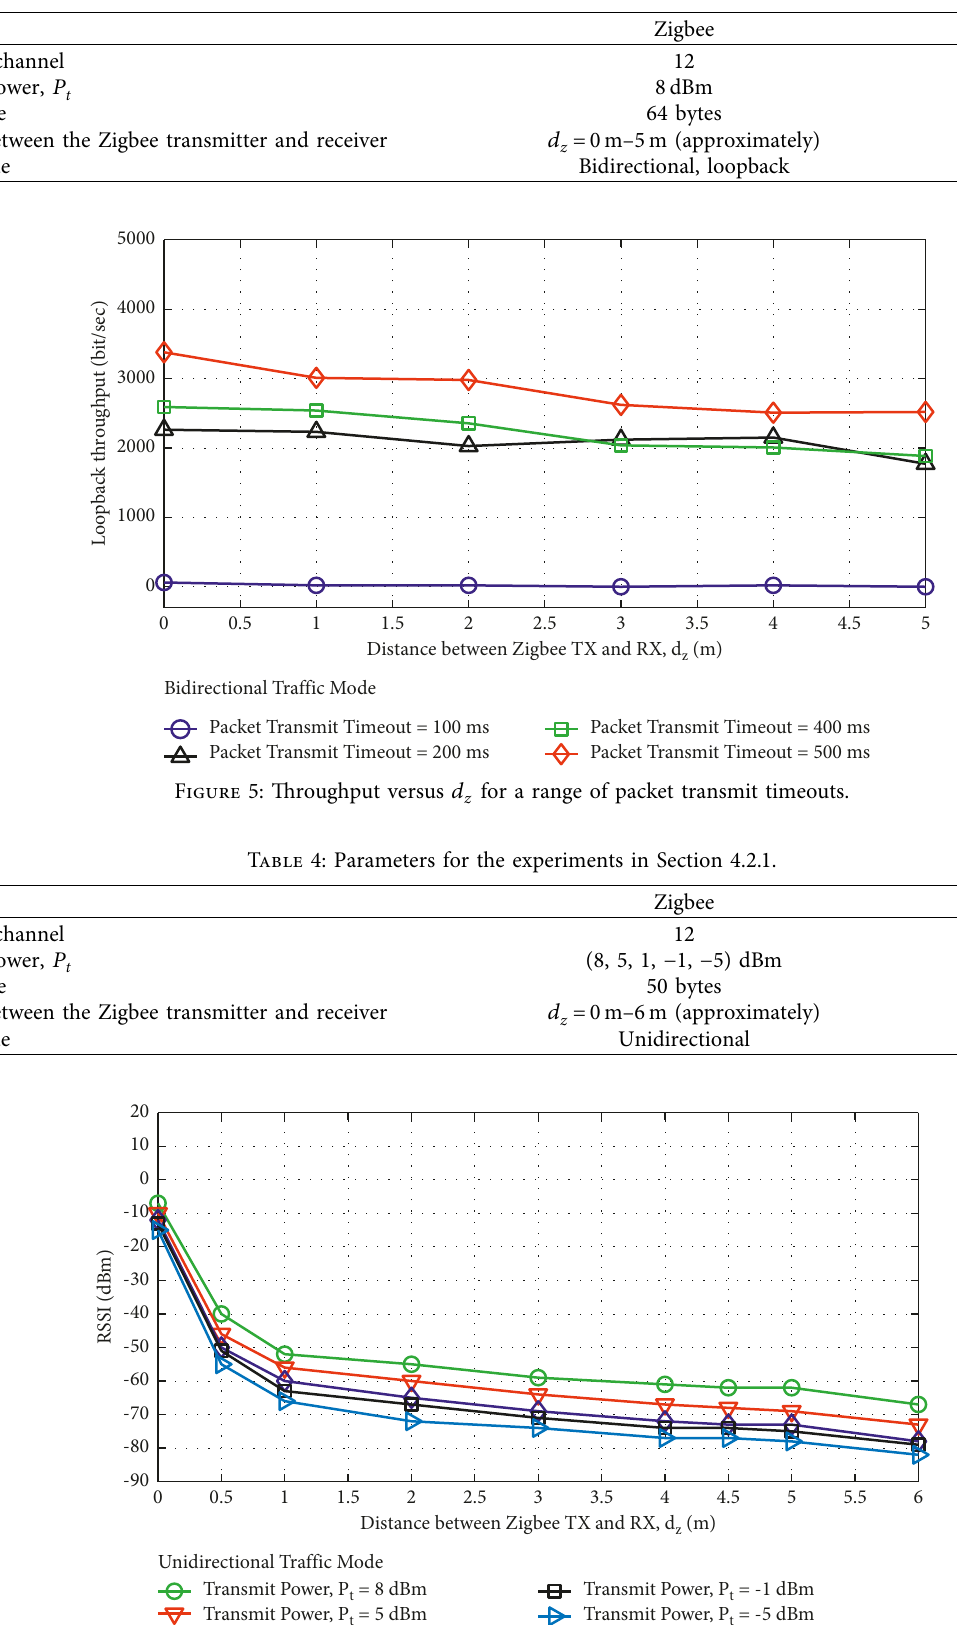
Table 3: Parameters for the experiments in Section 4.1.2.